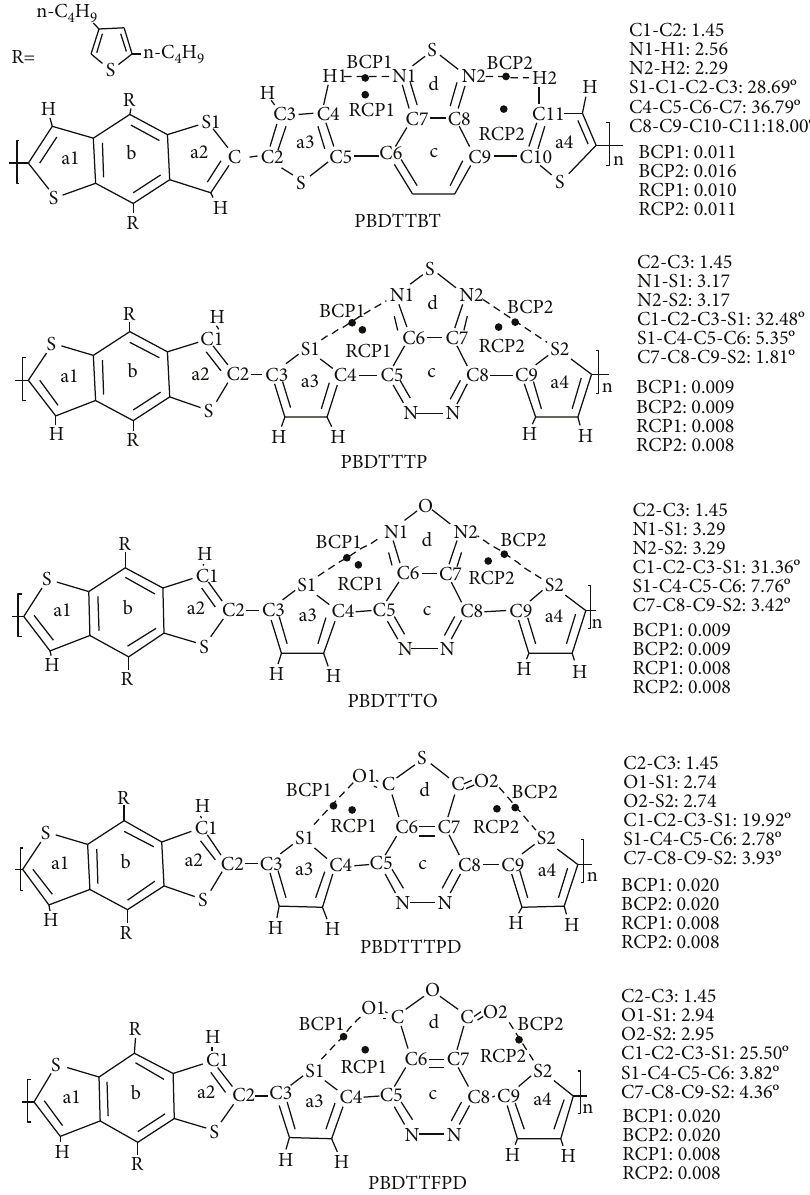
Figure 1: Structural parameters of copolymers and locations for calculated